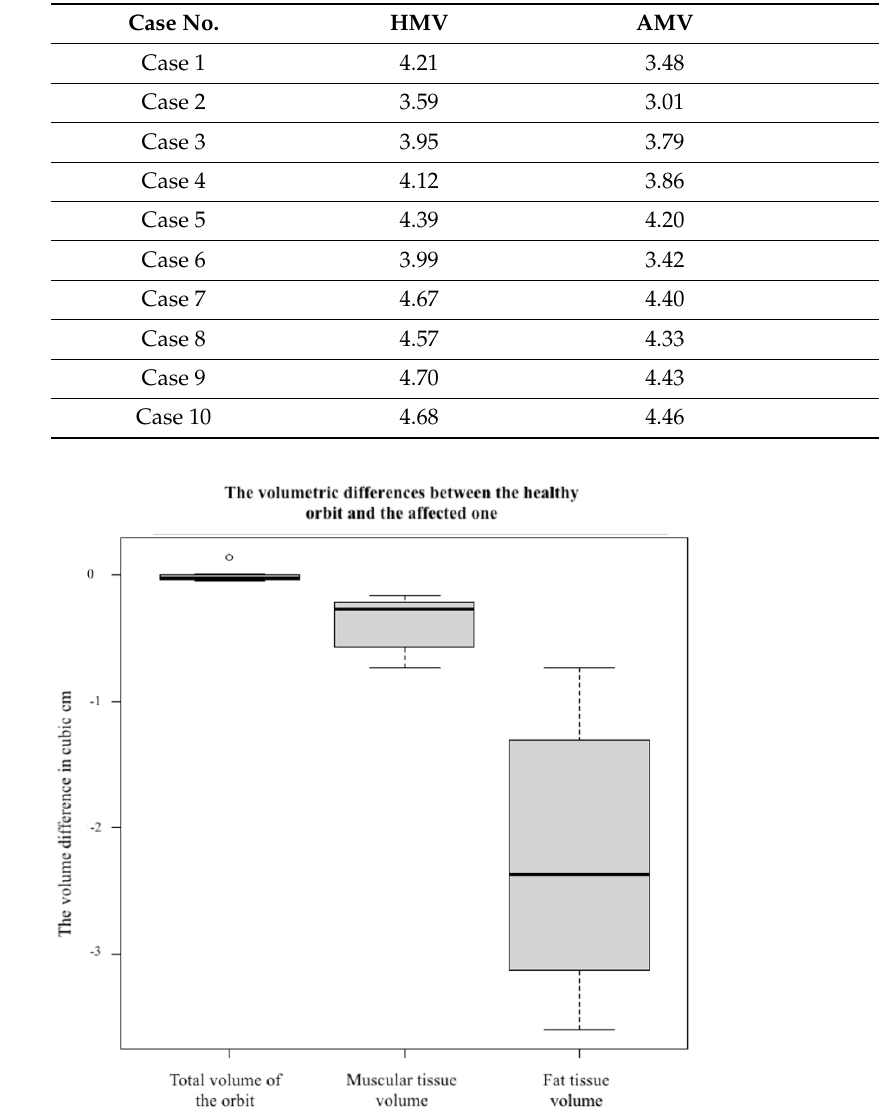
Table 4. Volume measurement of the muscular tissue.